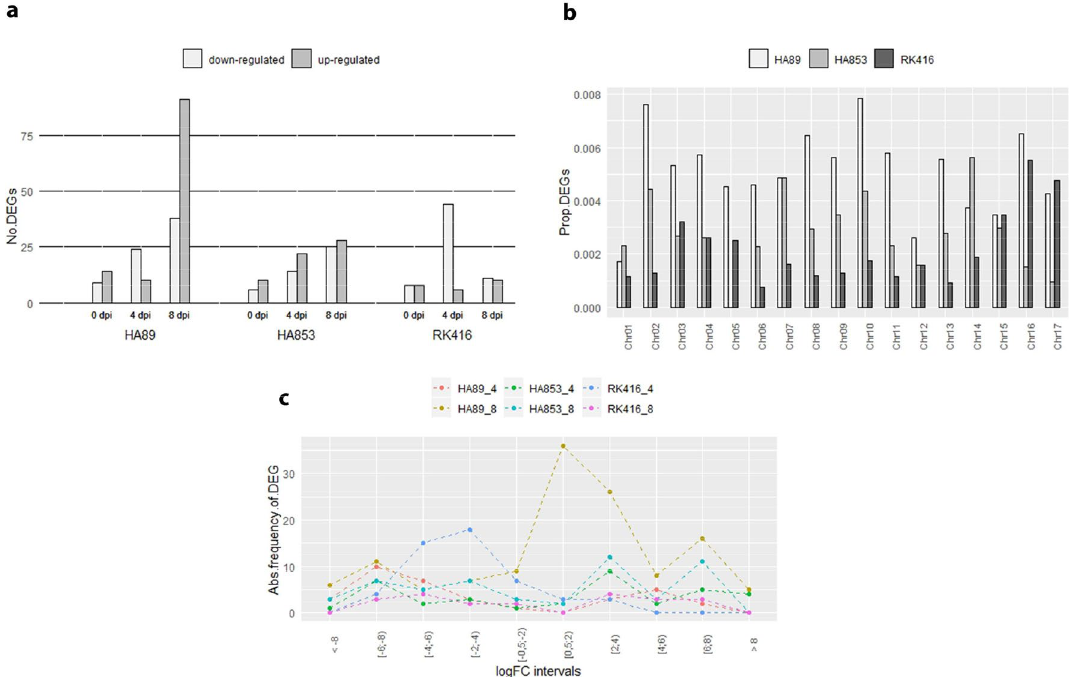
Figure 2. Analysis of DEGs. (a) Number of up- and down-regulated DEGs between I and N samples. (b) Proportion of DEGs relative to all expressed transcripts in each IL distributed across chromosomes. (c) Absolute Frequency of DEGs at different intervals of logFC values for each IL-time point combination (0 dpi not shown).